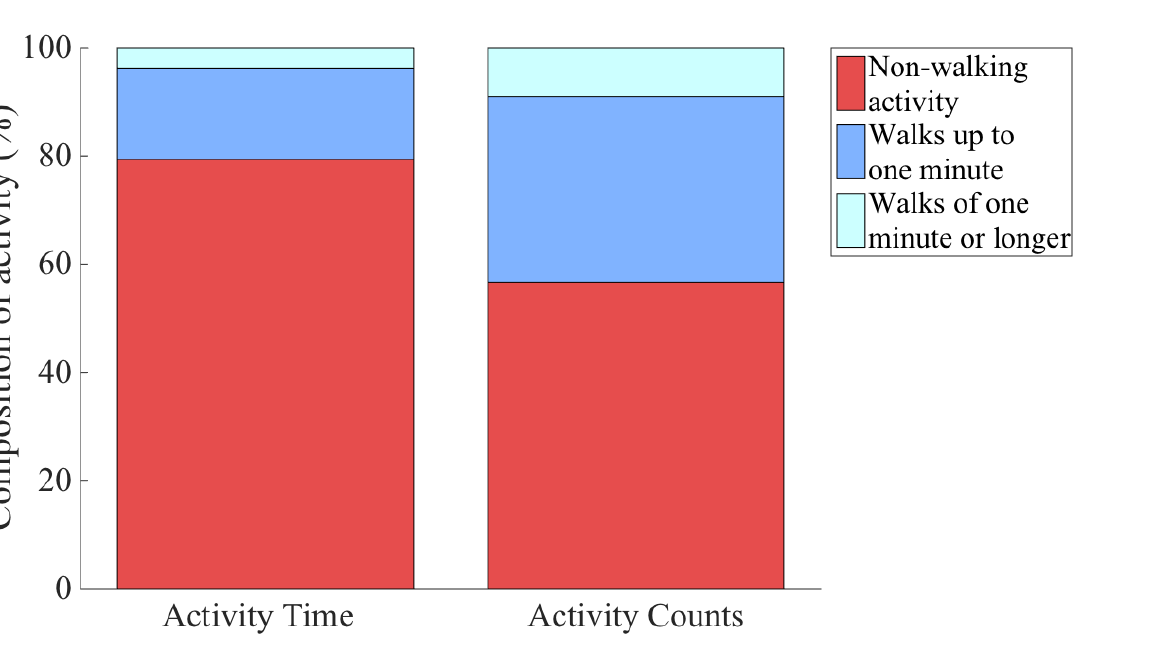
Figure 2. Composition of activity time and activity counts in older adults